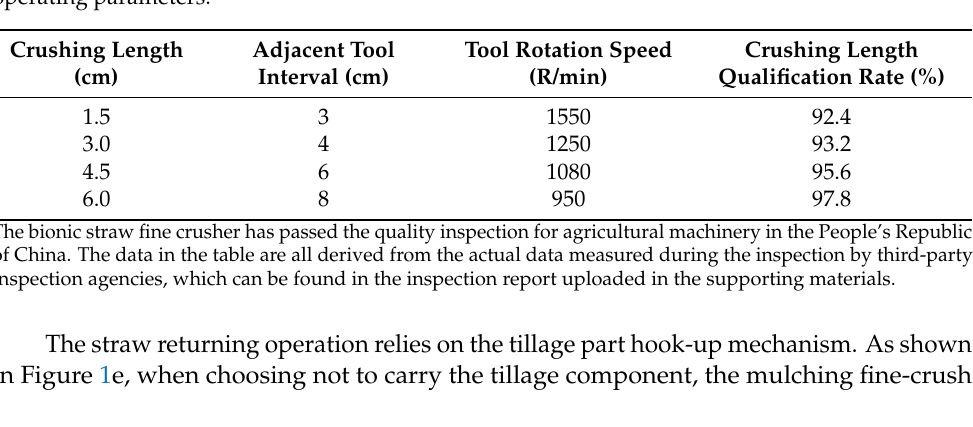
Figure 1. Operating principle of fine-crush straw returning and bionic straw fine crusher. ( a ). Structure and movement of locust mouthparts, ( b ). bionic fine-crush returning blade design principle, ( c ). drive system operating principle of the bionic fine-crush returning blade design, ( d ). difference in operational effect between the bionic straw fine crushing mechanism and the conventional straw returning mechanism, ( e ). bionic straw fine crusher for mulching returning operation, ( f ). bionic straw fine crusher for shallow burial returning operation, and ( g ). bionic straw fine crusher for deep tillage returning operation. Table 1. Comparison of straw crushing length and bionic straw fine crushing mechanism operating parameters.